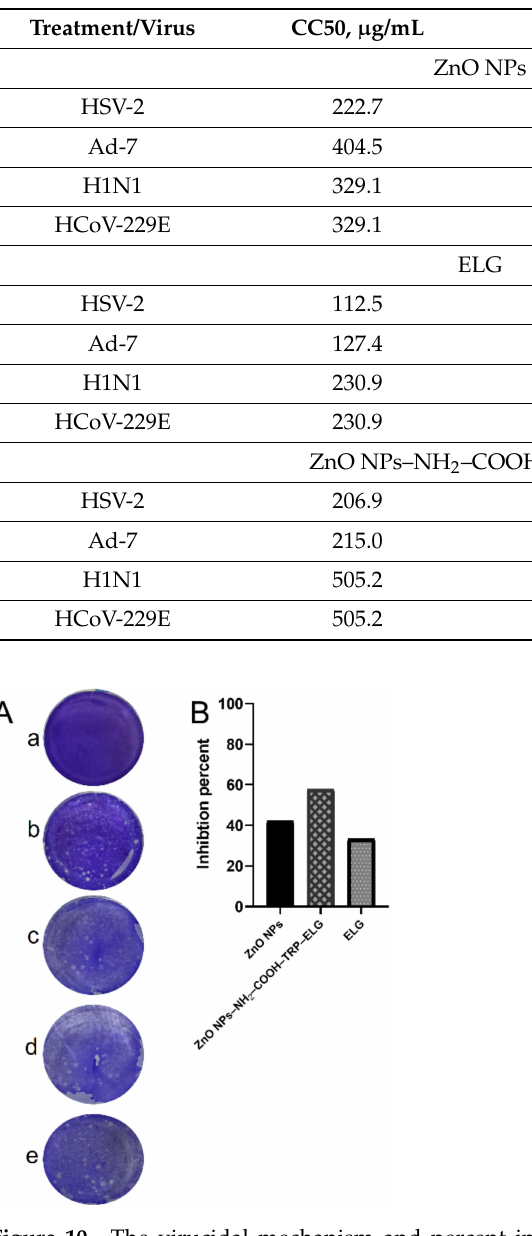
Table 2. The therapeutic effects calculated from the CC50 and IC50 of different materials.